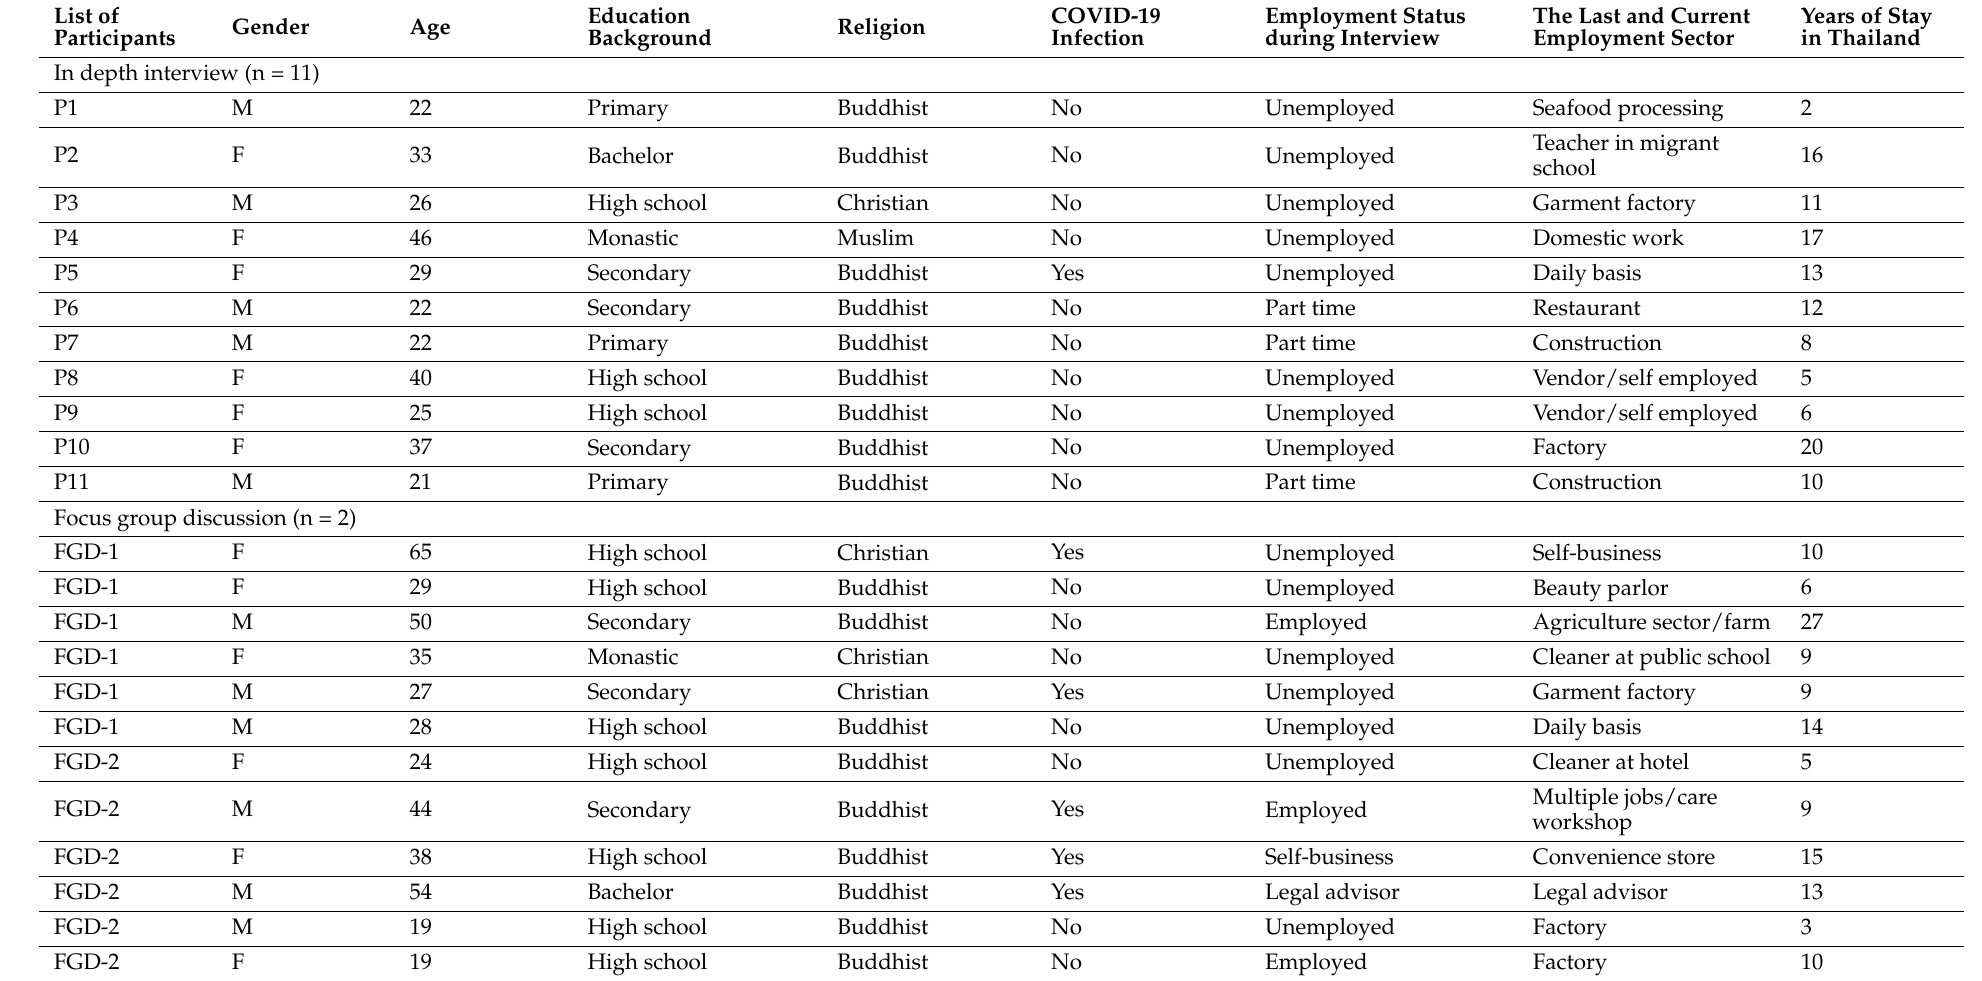
Table 2. Sociodemographic characteristics of the qualitative study participants (IDIs and FGDs) (n =